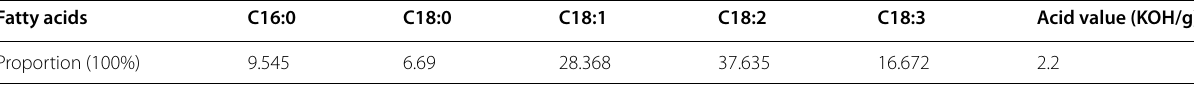
Table 5 Composition of hydrolyzed fatty acid by rubber seed oil Fatty acids